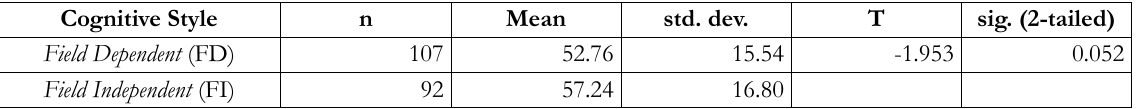
Table 7. The Independent Sample t-Test Cognitive Style for Initial Test